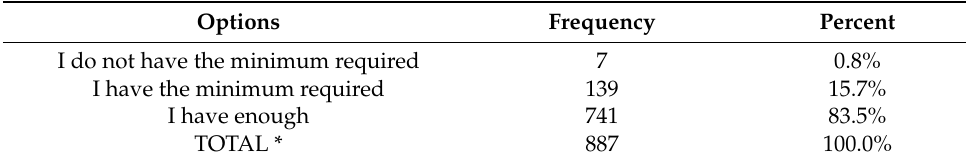
Table 1. In terms of equipment (computers, internet) and space, do you feel you have everything you need for distance